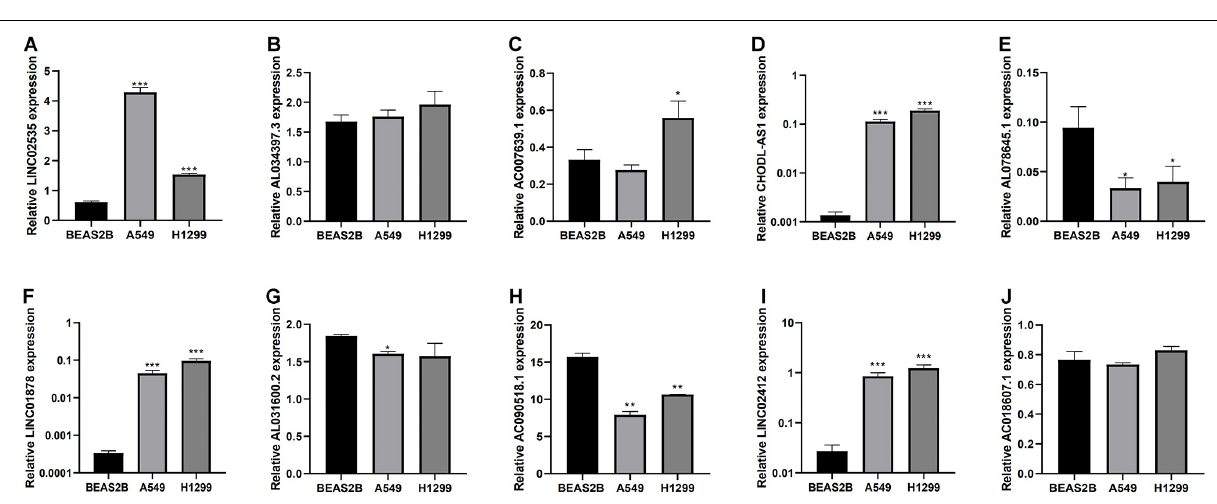
FIGURE 8 | Expression of lncRNAs from the risk model in LUAD cell lines and bronchial epithelial cell. (A–J) Expression of 10 LncRNAs from the risk model in LUAD cancer cell lines and bronchial epithelial cell. * P < 0.05, ** P < 0.01, and *** P <